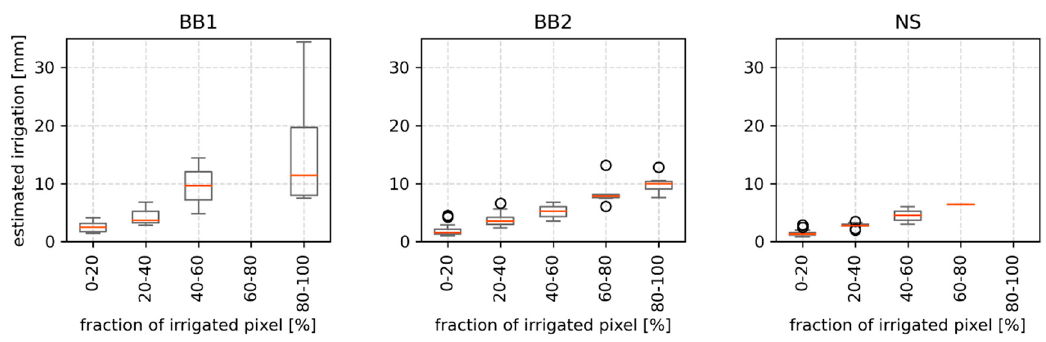
Figure 5. Median irrigation heights of individual events estimated for each pixel throughout the irrigation period, grouped by the fraction of pixel irrigated.